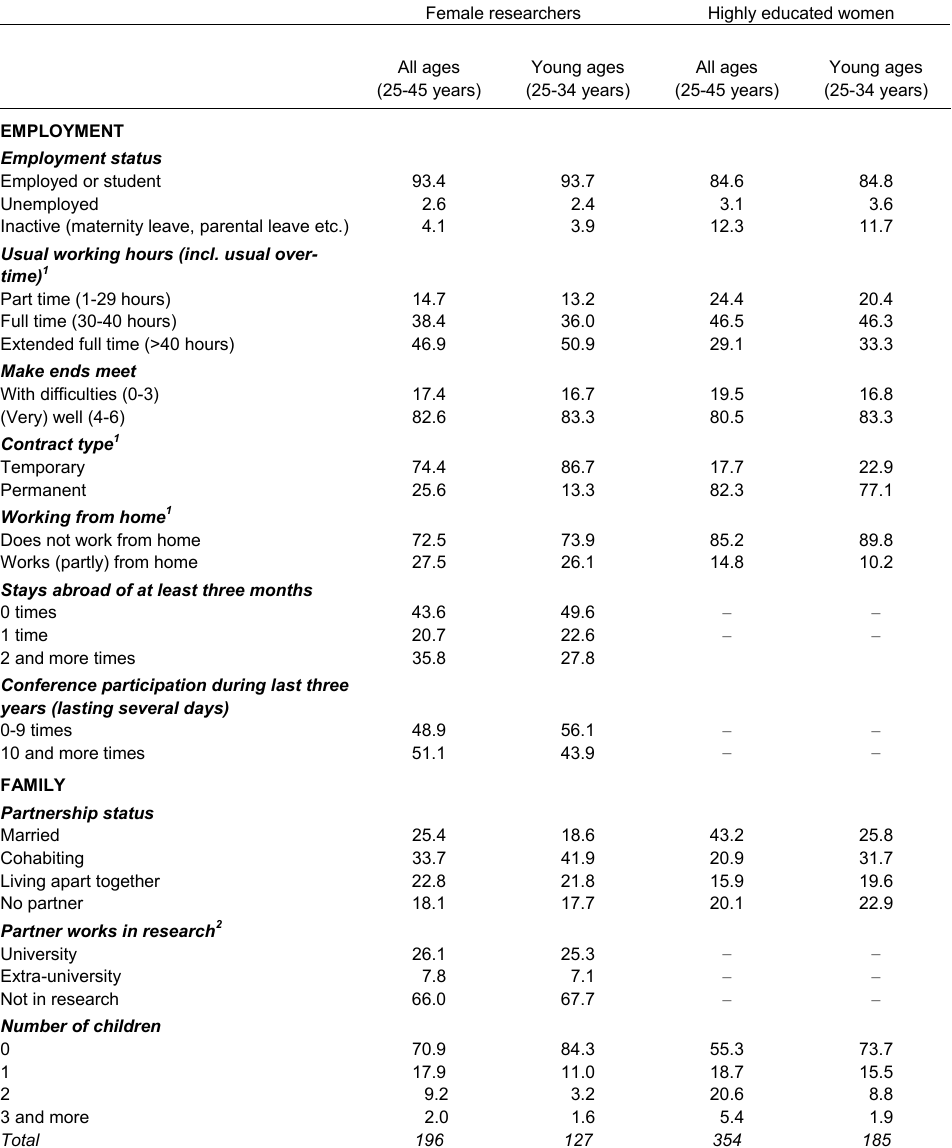
Table A.1 : Employment and family characteristics of female researchers and other highly educated women